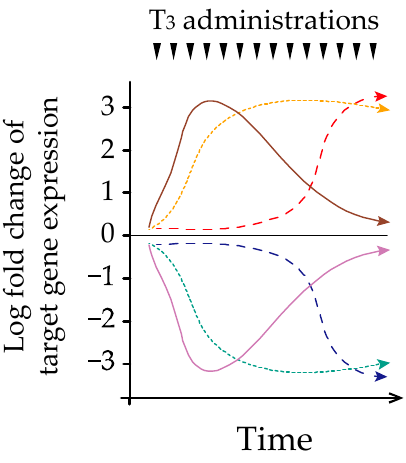
Figure 2. Schematic explanation of three differential expression patterns of both positively and negatively regulated thyroid hormone-responsive genes during chronic triiodothyronine (T 3 ) treatment. Gene expression microarrays were performed on liver harvested from mice before and during chronic T 3 treatment [33]. Both positively and negatively regulated T 3 responsive genes were identified that could be divided according to their characteristic into three general types: genes regulated only acutely by T 3 (solid line), those regulated only chronically by T 3 (dashed line), and those regulated by both treatments (dotted line). Arrowheads represent liothyronine injections.